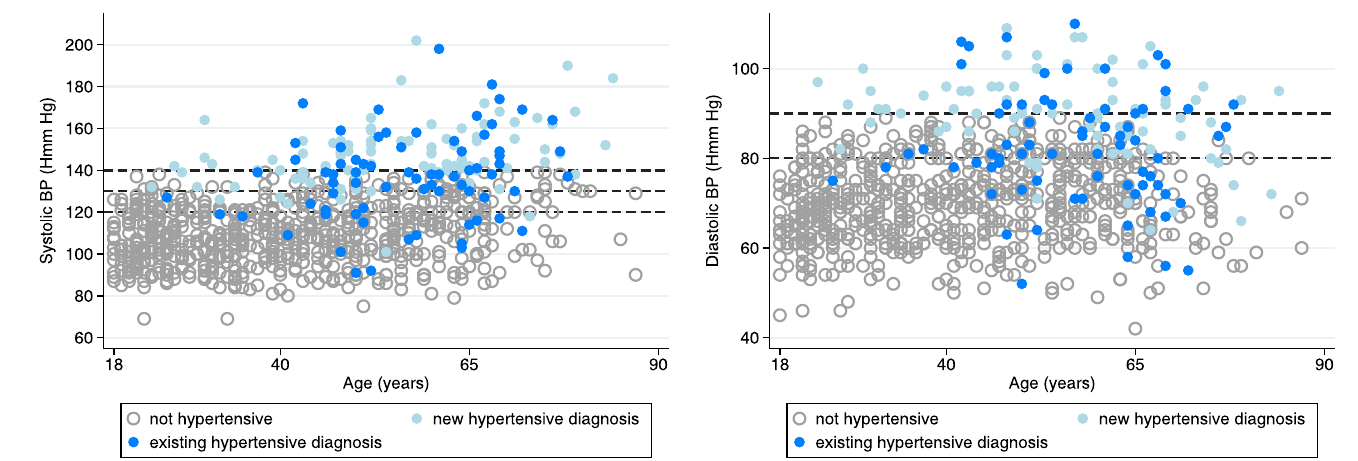
Fig 5. Systolic and diastolic blood pressure by age in those with and without hypertension and new vs pre-existing diagnoses. Footnotes: Hypertension = SPB � 140 mmHg OR DBP � 90 mmHg OR previous diagnosis and currently taking recognised anti-hypertensive medication. Systolic blood pressure (SBP): y-axis: � 120 mmHg indicates cut-off for elevated SBP; � 130 mmHg indicates cut off for stage 1 hypertension; � 140 mmHg indicates cut-off for stage 2 hypertension. Diastolic BP (DBP): y-axis: � 80 indicates cut-off for elevated DBP; � 90 indicates cut off for stage 2 hypertension (AHA 2017 criteria